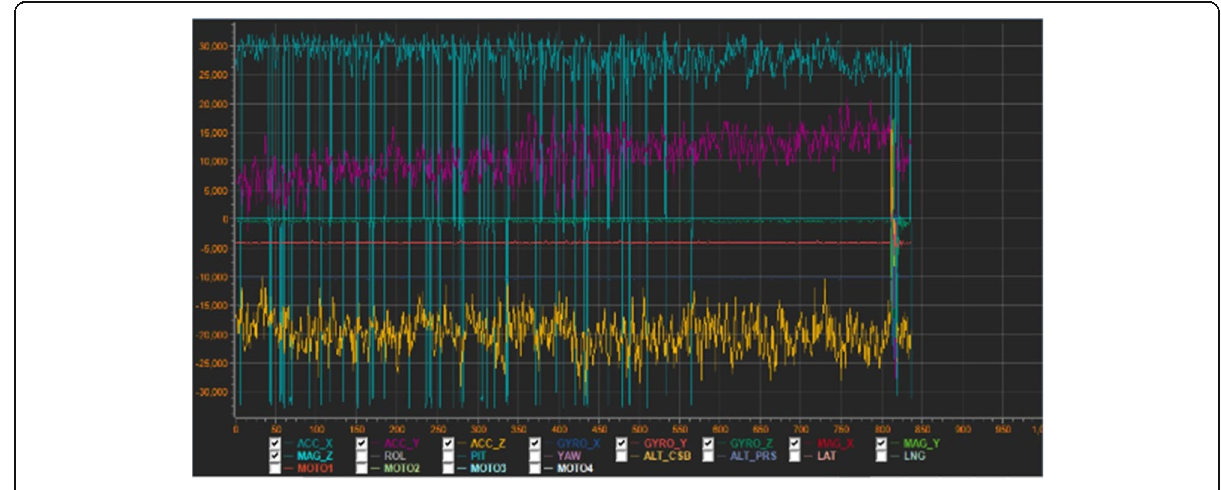
Fig. 36 The output waveform of gyro sensors